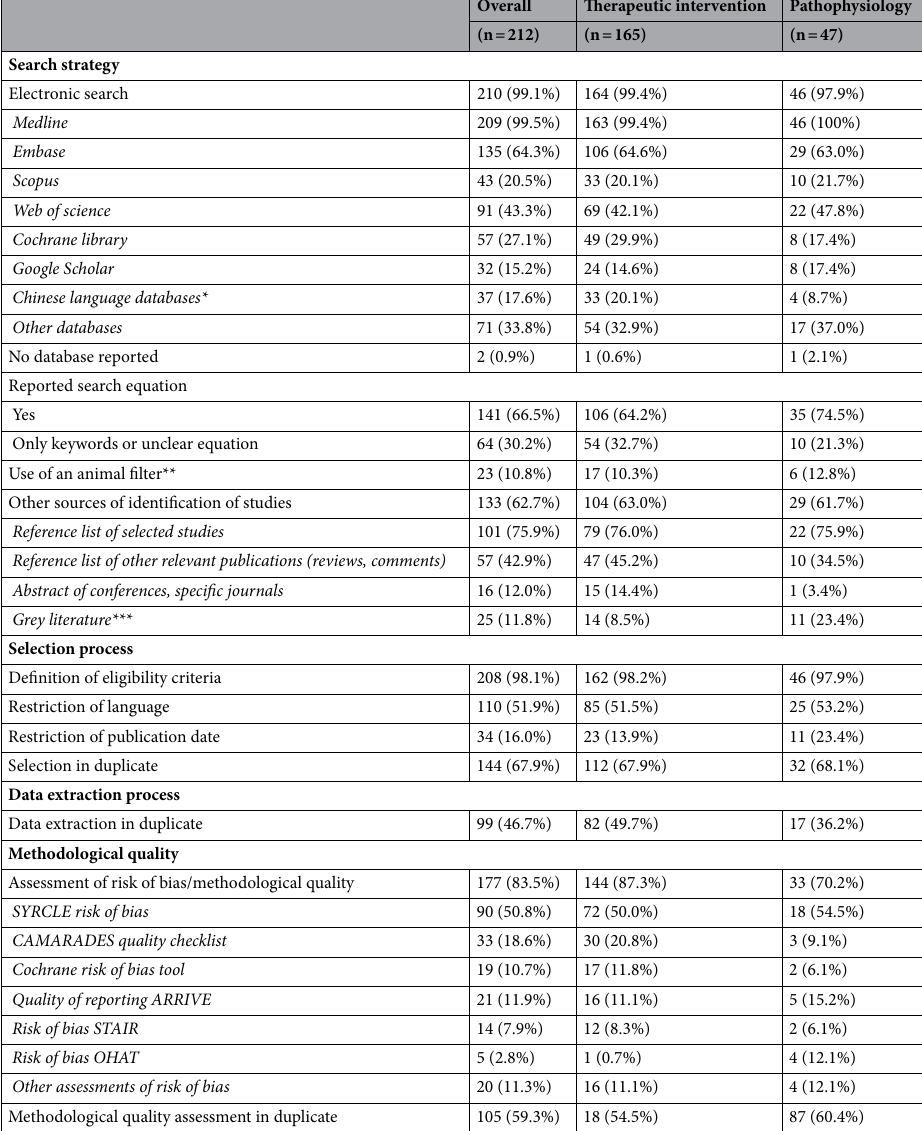
Table 2. Methodological characteristics of included systematic reviews. *Chinese National Knowledge Infrastructure, WanFang, VIP, Chinese Biomedical Literature. **As published by Hooijmans et al., and de Vries et al. 47,50 . ***Google search engine queries, OpenGrey website, experts, unpublished data, others